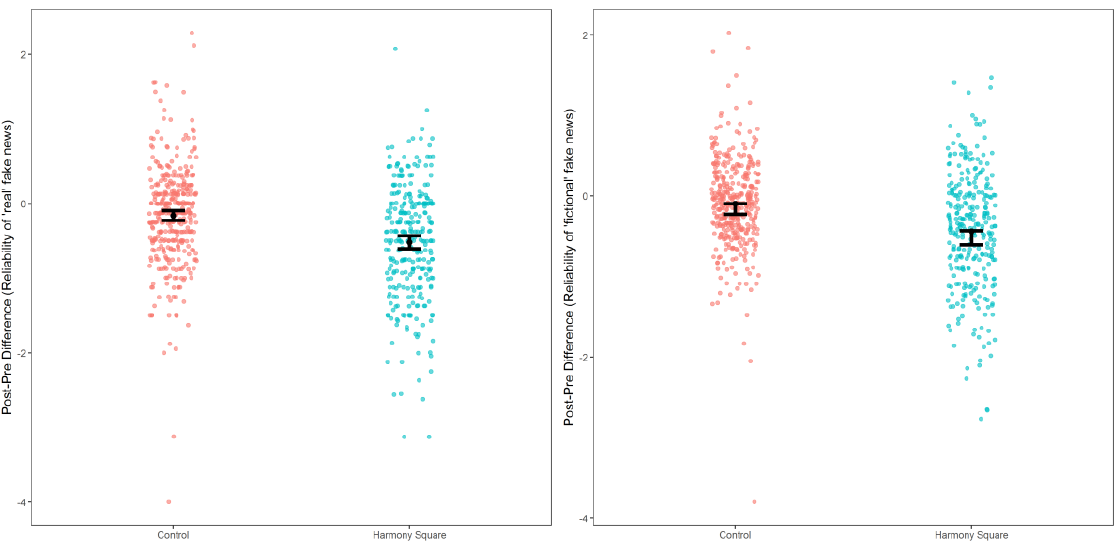
Figure 2. Pre-post difference scores for the reliability judgments for both “real” and “fictional” misinformation, for the treatment (panel A) and control groups (panel B). The dots represent the data points. The black dot in the middle indicates the mean value. Error bars represent 95% confidence intervals. In both plots, the distribution for the Harmony Square group is shifted downwards, indicating that people found fake news posts significantly less reliable after playing in the treatment group. Separate bars for pre and post scores (by condition) are provided in Supplementary Figure